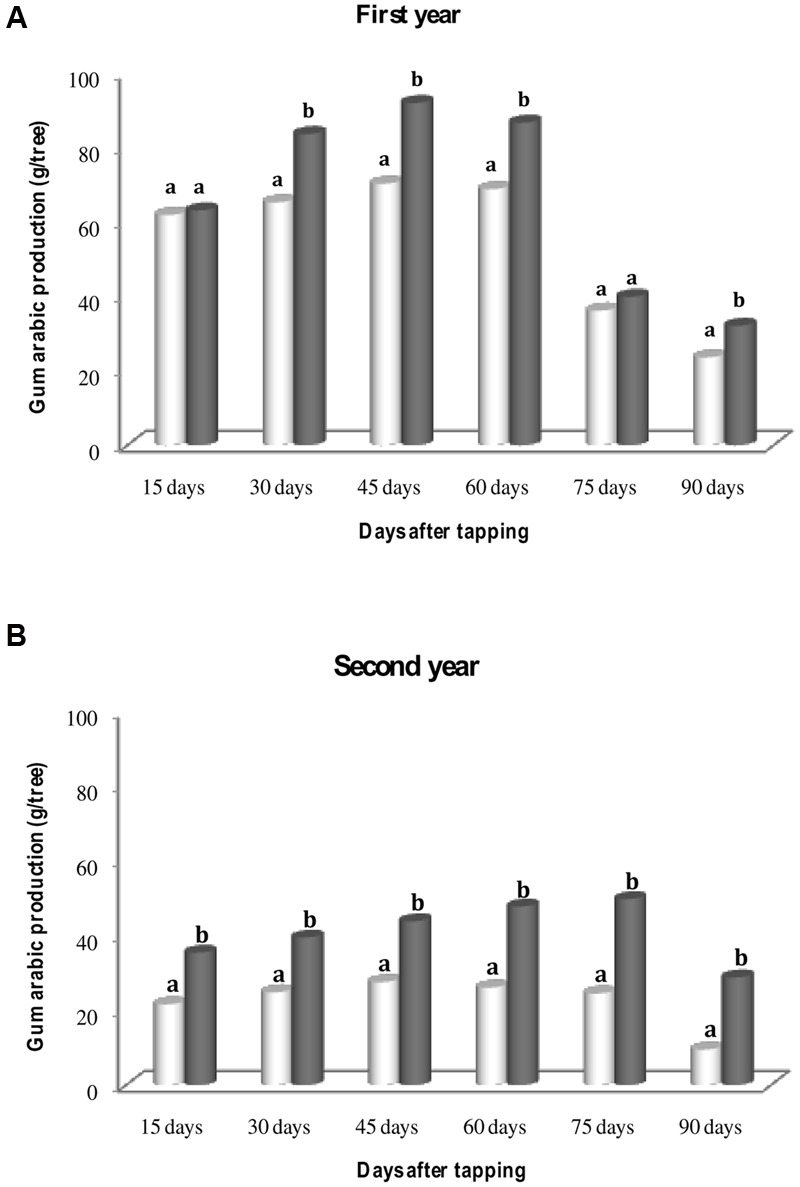
Gum arabic produced every 15 days for 3 months by uninoculated and inoculated 13-year-old S. senegal trees during 1st year (A) and 2nd year (B). For each date of harvest, bars with same letter comparing rhizobial inoculation effect are not significantly different at P < 0.05 (Newman–Keuls test).